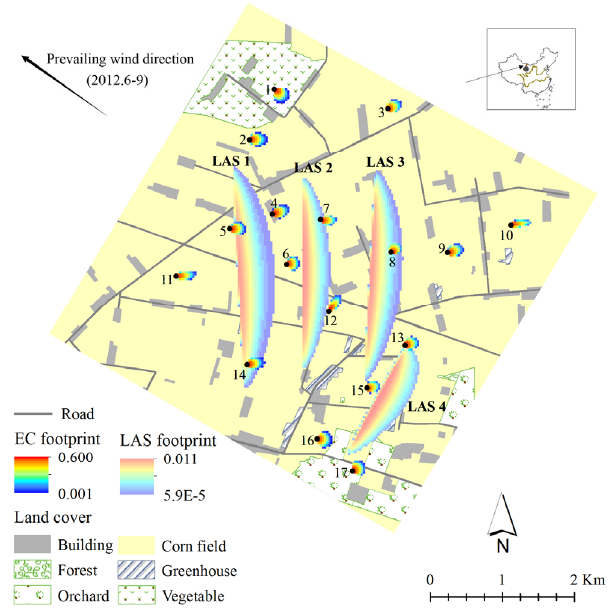
Figure 1. Yingke-Daman irrigation district in the Heihe River Basin, China (modified from [20], footprint in 2012/6/24).